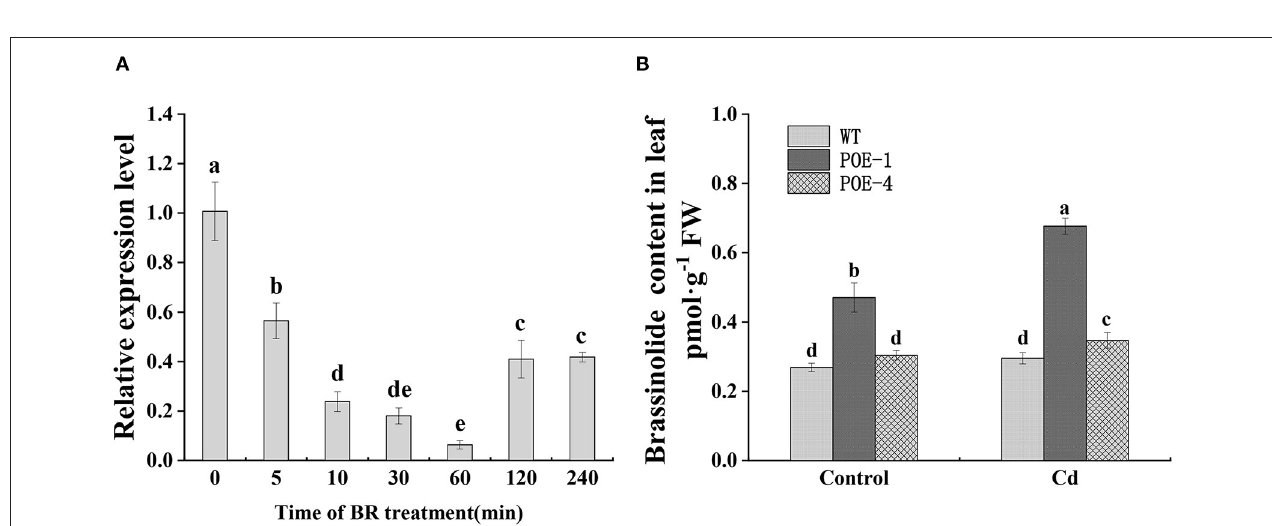
FIGURE 3 | Expression pattern of PscCYP716A1 under exogenous BR treatment and endogenous BR level in different lines. (A) RT-qPCR analysis of PscCYP716A1 in response to 0.1-mM BR treatment for a different time, the expression level at time 0 was set to 1. The different letters indicate significant differences between different time points ( p < 0.05) (B) PscCYP716A1 promotes endogenous BR content in poplar. Different letters indicate significant differences between treatments. All of the data are shown as the mean ± SD of three biological